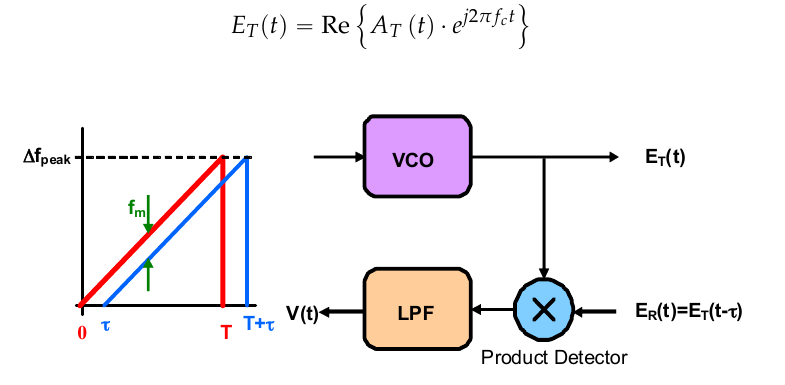
Figure 2. Block diagram of the linear FM radar.